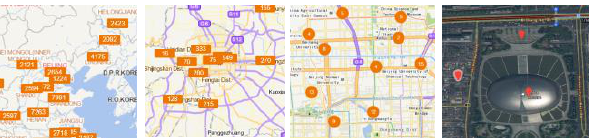
Figure 6. Visualization effect of different